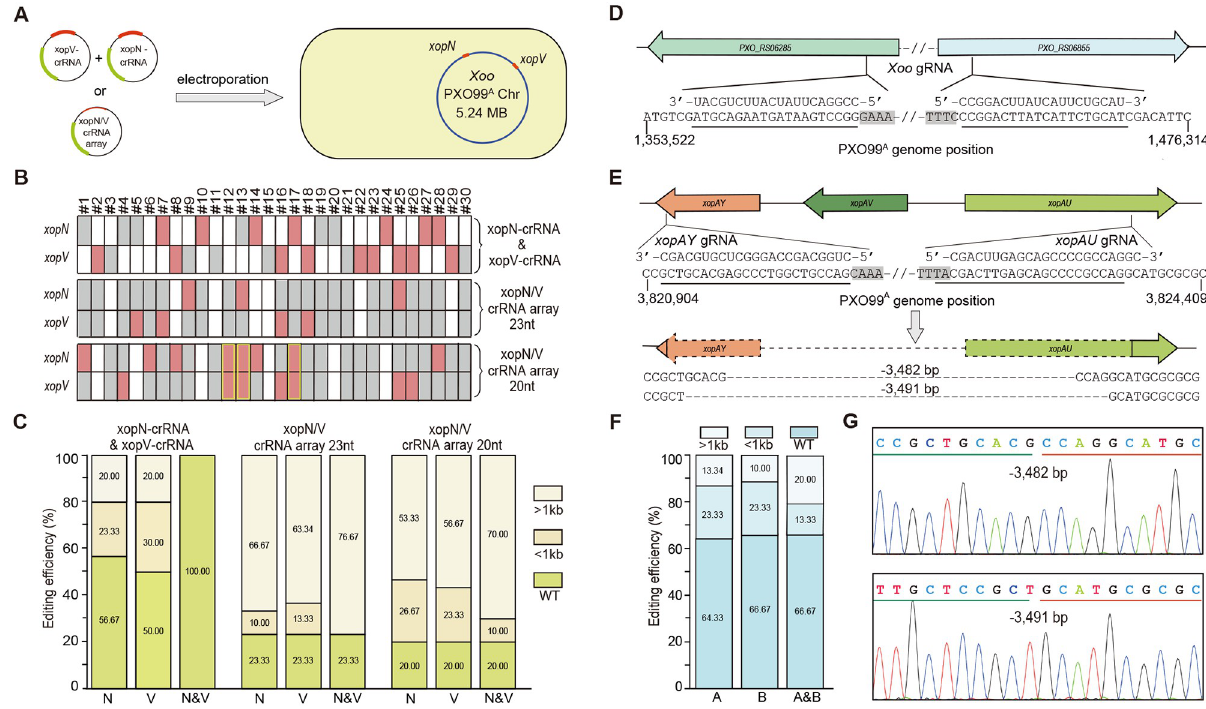
Fig 2. Multiplex gene knockout and accurate chromosomal DNA fragment deletion in Xoo PXO99 A by CRISPR/FnCas12a. (A) Schematic illustration of pHM1B4-mediated simultaneous gene editing of xopN and xopV in PXO99 A with different approaches. Approach I: Equal amounts of plasmid DNA of pHM1B4 - xopN-crRNA and pHM1B4 - xopV-crRNA were simultaneously electroporated into PXO99 A . Approach II: A single pHM1B4 plasmid carrying a crRNA array of 20- or 23-nt protospacers was electroporated into PXO99 A . The relative positions of xopN and xopV genes in the PXO99 A genome (NC_010717.2) are marked in red. (B) Thirty independent colonies were randomly picked for genotyping by tilling PCR amplification across ~3 kb region around the target sites. Each column represents the identities of xopN and xopV in a single independent colony. The blank, grey, and red boxes denote wild type, large deletions ( > 1 kb), and small deletions ( < 1 kb), respectively. Colonies bearing small deletions in both xopN and xopV are framed by yellow rectangles. #1–30, colony No.; crRNA-xopN & crRNA-xopV, Xoo cell transformation with two pHM1B4 plasmids (Approach I); xopN/V crRNA array, Xoo cell transformation with a single pHM1B4 plasmid carrying 20- or 23-nt protospacer (Approach II). (C) Statistical graphics showing the percentage of various deletion mutations in xopN and xopV in regard to different genome editing approaches. N, xopN ; V, xopV ; N&V, xopN and xopV . Colonies bearing small deletions in both xopN and xopV were considered as < 1kb category, colonies showing a mixed pattern with both < 1kb and a > 1kb deletions were considered as the > 1kb category, and colonies showing a mixed pattern with both wild type and > 1kb deletion were considered as the WT category. No co-editing events was detected after transformation in Approach I; Co-editing of both xopN and xopV with crRNA array of 23-nt protospacers occurred in all positive colonies and resulted in large deletions. (D) Genome editing of two homologous genes ( PXO_RS06285 and PXO_RS06855 ) using crRNA with a 20-nt protospacer. (E) Schematic illustration of precise deletion of a 3.84-kb xopAY - AV - AU gene cluster using 23-nt paired gRNAs. Surviving colonies were genotyped by PCR amplification and Sanger sequencing. The sequences below are the junction sequences with the deletions (dashed lines). The target regions are underlined and the PAM sequences are marked by the black shadow in ( D ) and ( E ). (F) Statistical graphics showing the percentage of various deletion mutations in PXO_RS06285 and PXO_RS0685585 using approach II (20-nt protospacer). A, PXO_RS06285 ; B, PXO_RS06855 ; A&B, both PXO_RS06285 and PXO_RS06855 . (G) Sanger sequencing chromatograms of the deletion mutants shown in (E). The junction sequences are underlined in different colors (green and